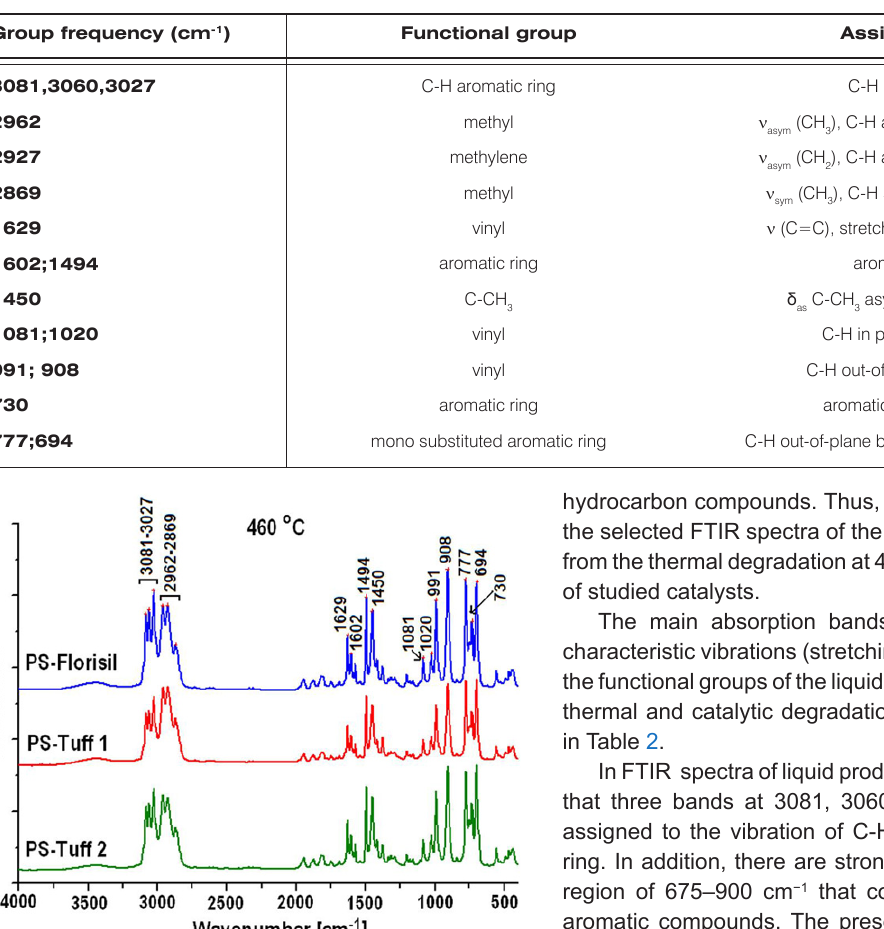
Table 2. The assignments of absorption bands of studied liquids